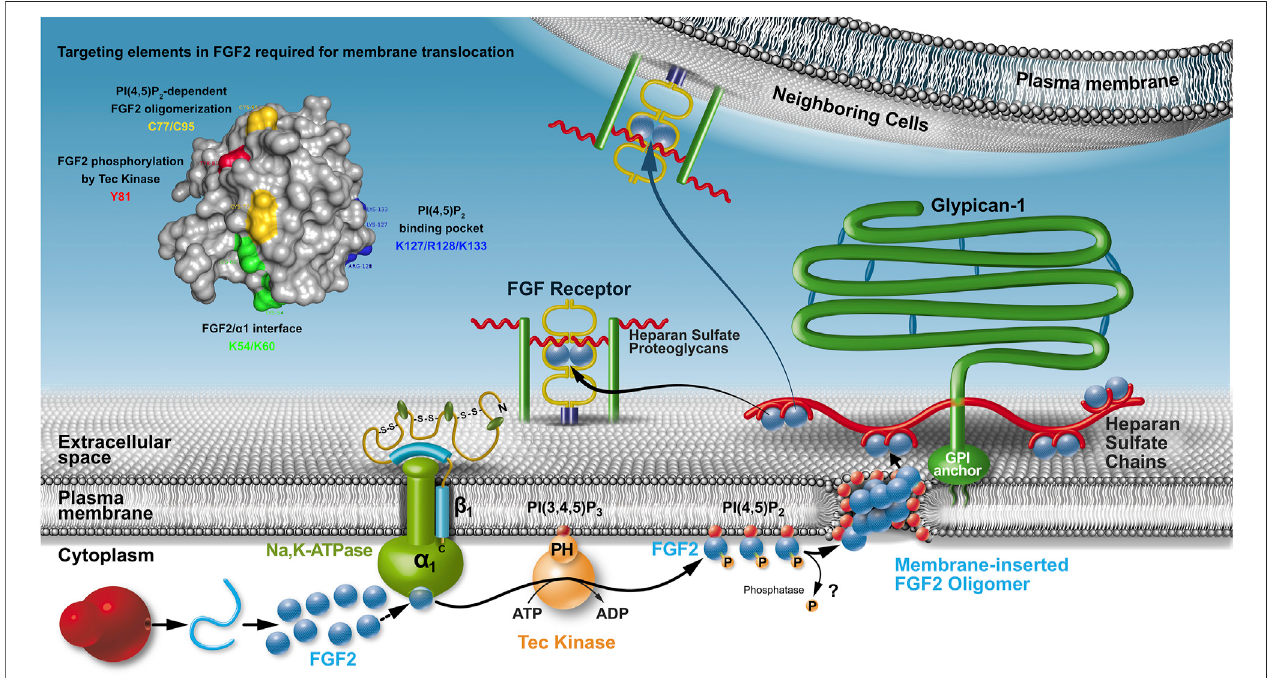
FIGURE 1 | The unconventional secretory pathway of FGF2. Localization, molecular machinery, and mechanism as well as cis elements in FGF2 that are required forFGF2translocationacrosstheplasmamembraneofeukaryoticcells.WhereasitisclearthattheNa,K-ATPaseareupstreamofPI(4,5)P 2 ,theorderofsequentialFGF2 interactions with the Na,K-ATPase and Tec kinase remains to be determined. It is also unclear whether FGF2 is secreted as a phosphorylated protein or whether a phosphatase removes this modi fi cation before FGF2 membrane translocation